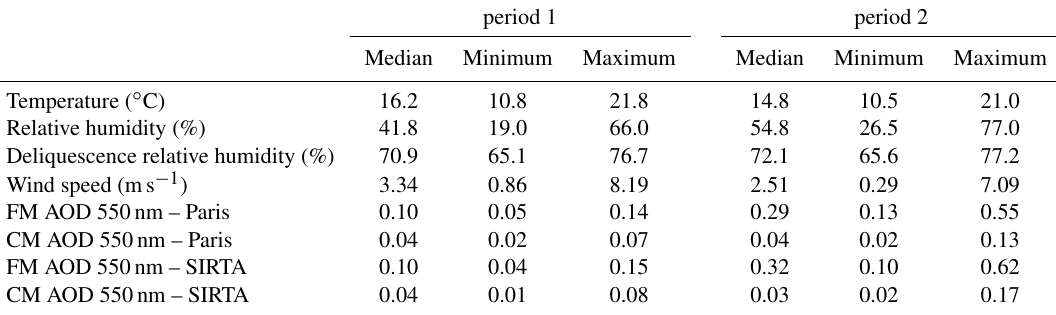
Table 2. Meteorological variables at the surface and AOD during 26–27 March (period 1) and during 28–30 March (period 2), displayed by the median, minimum and maximum values for temperature, relative humidity, deliquescence relative humidity, and wind speed and direction – as well as AOD in its fine mode (FM) and coarse mode